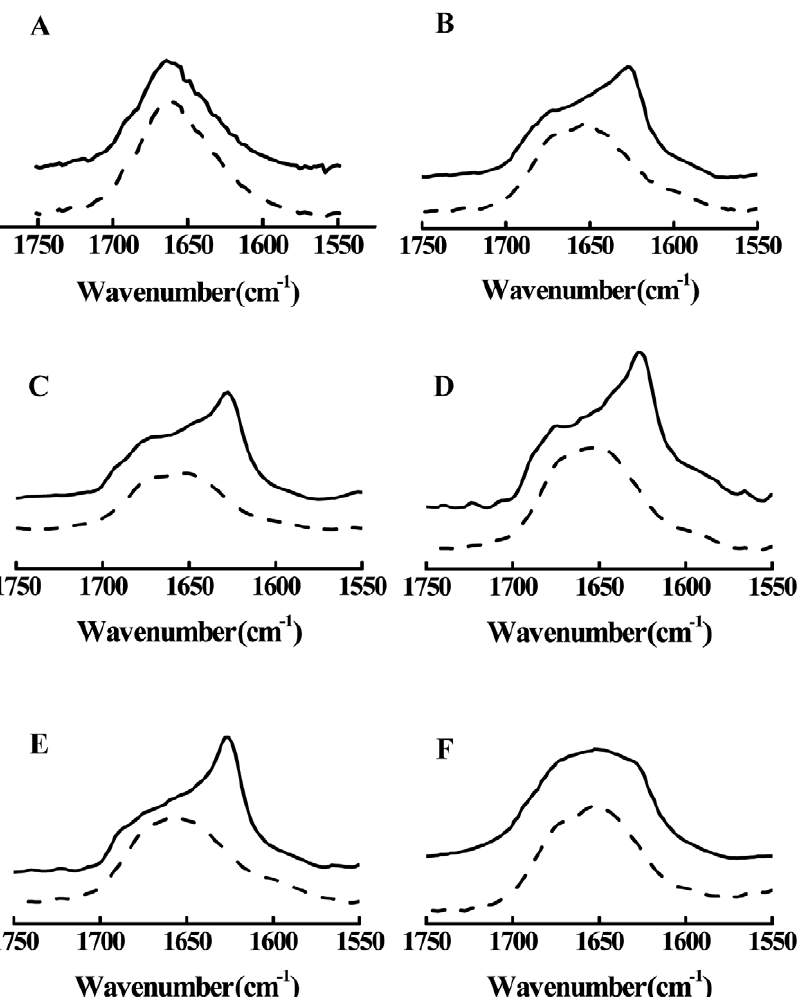
Figure 3. Effect of lipid vesicles in the FTIR spectra of the amide I band of wtBO 16 (solid lines) and W8A (dashed lines) at 25 6 C. Peptides in 100% (A) and 50% (B) DMSO or in the presence of LUVs of different compositions: PC (C), PC:PE:PI:Cho (D), PC:PE:SPM:Cho (E), or in the presence of lipid rafts from Vero cells (F). The peptide concentration was 19.5 mM, and the LUV concentration was 44 mM. The ordinate represents absorption (in arbitrary units).